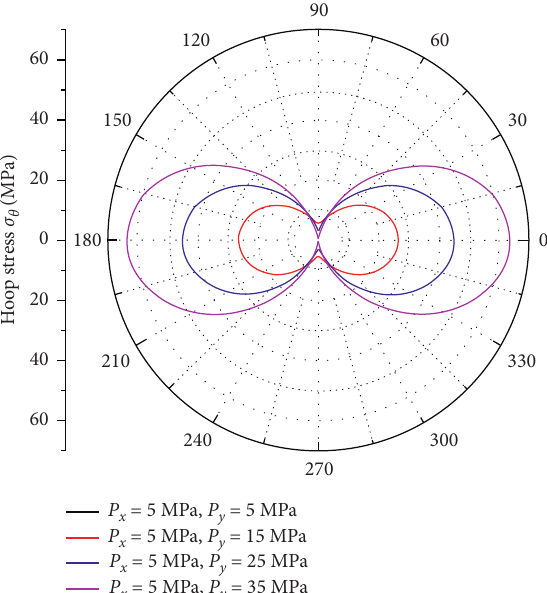
Figure 18: Hoop stress distributions along the edge of the borehole under the different values of P